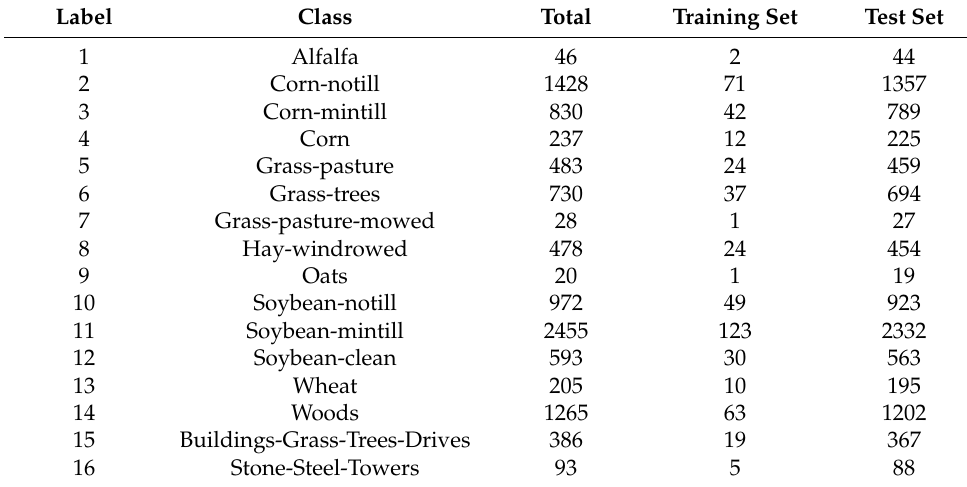
Table 2. Number of training and test samples for the IP dataset.